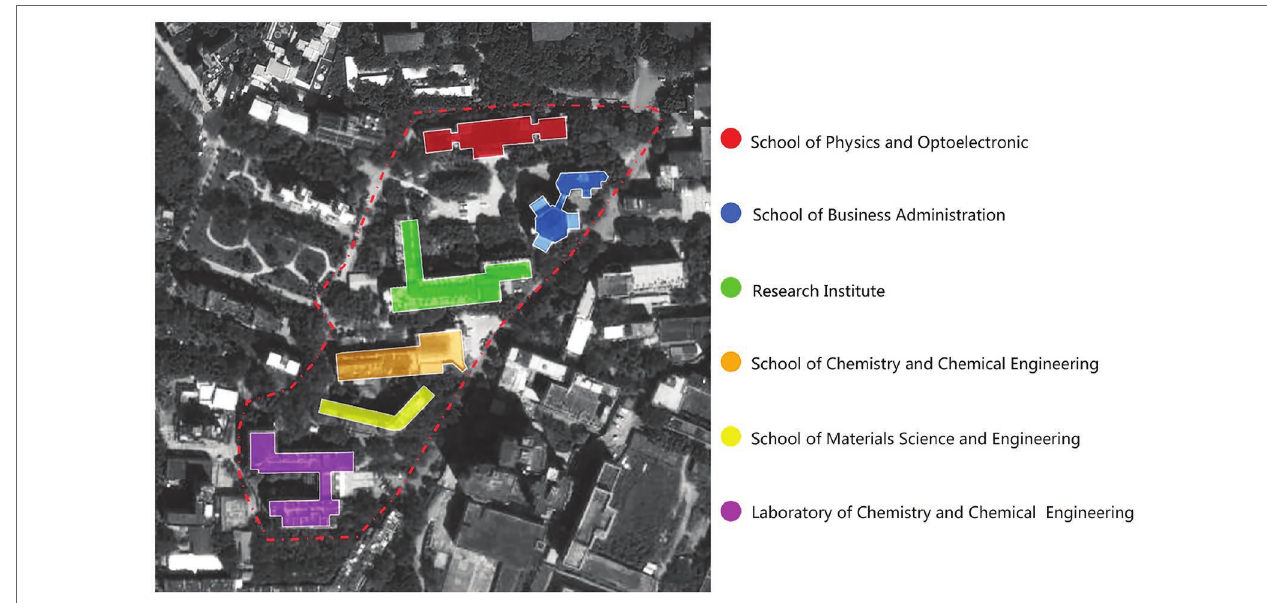
FIGURE 1 | The research district in SCUT campus.